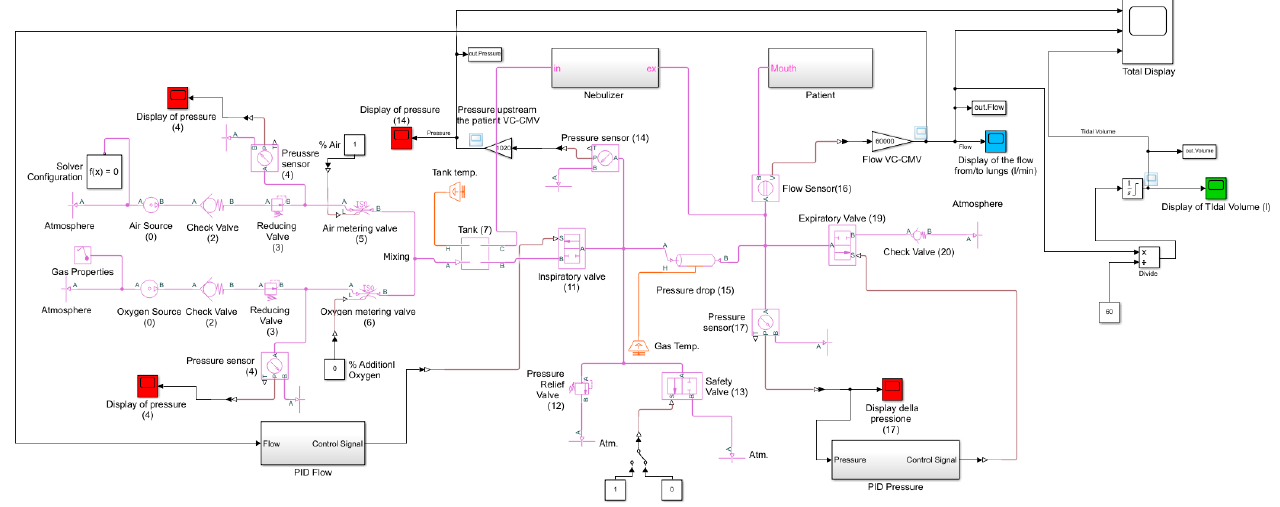
Figure 13. VC − CMV simulation code produced with Simulink (Simscape Fluids (gas)